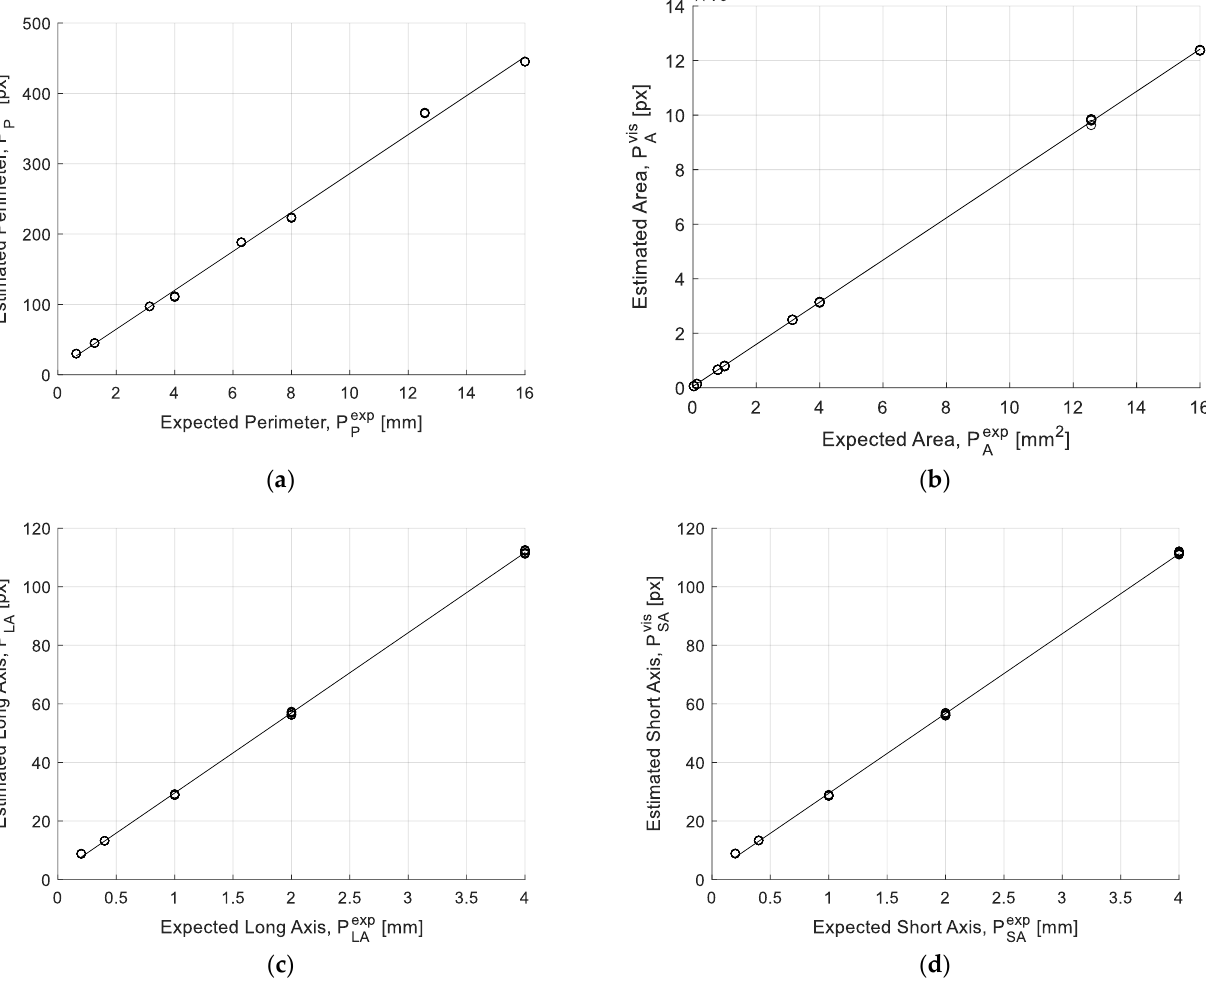
Figure 5. Transduction diagrams for ( a ) perimeter, ( b ) area, ( c ) bounding rectangle long and ( d ) short axes.